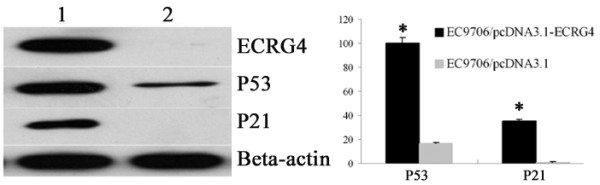
ECRG4 may be involved in p53 pathway. Representative photos and statistic plots of relative protein expression levels in EC9706/pcDNA3.1-ECRG4 and EC9706/pcDNA3.1. Analysis of cell's total proteins by Western blot showed that p53 and p53 target gene p21 expressions were increased in EC9706/pcDNA3.1-ECRG4 cells compared with in EC9706/pcDNA3.1 cells (P < 0.05). Lane 1: EC9706/pcDNA3.1-ECRG4; Lane 2: EC9706/pcDNA3.1. *, P < 0.05, compared with EC9706/pcDNA3.1.